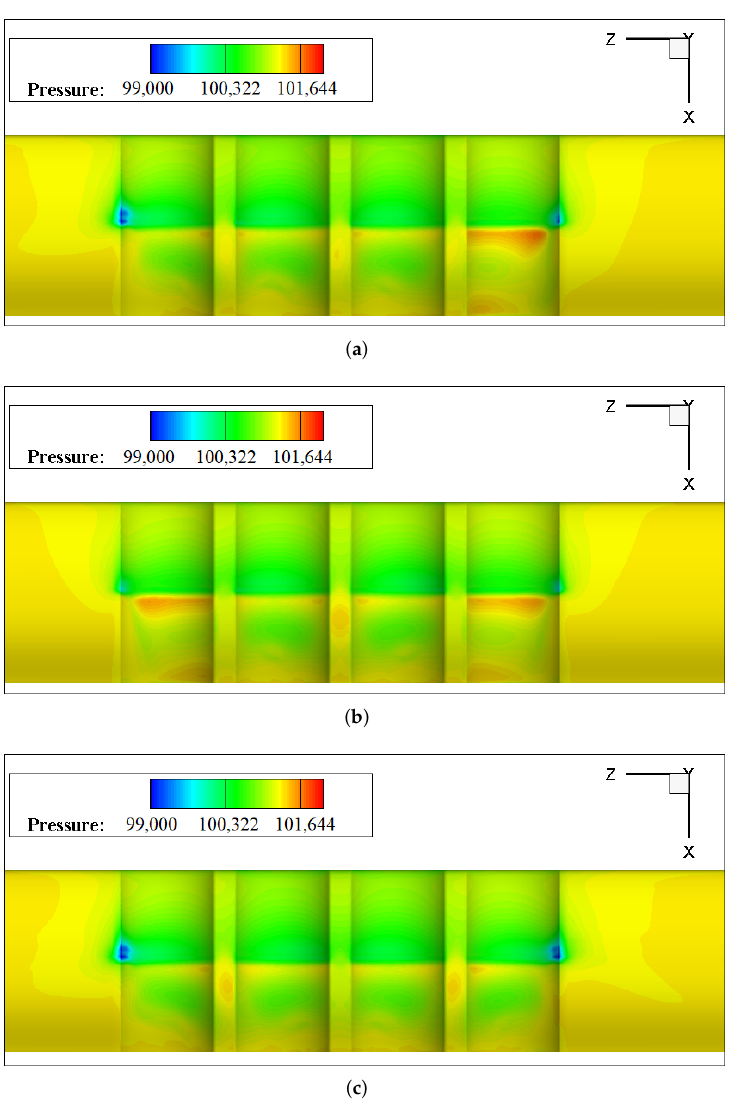
Figure 15. Pressure contour of different configuration. ( a ) Multi-propeller CW (NNNN); ( b ) Multi- propeller CW (NPNP); ( c ) Multi-propeller CW